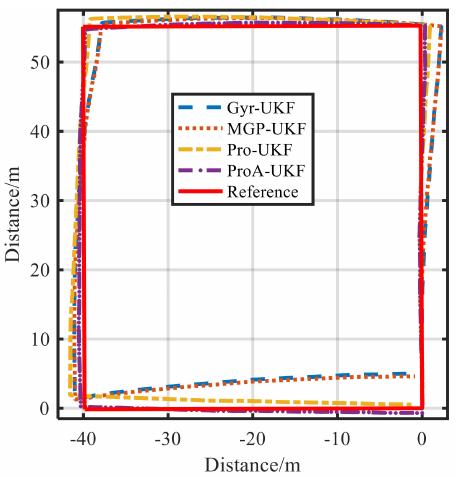
Figure 8. Trajectories of di ff erent heading estimations for